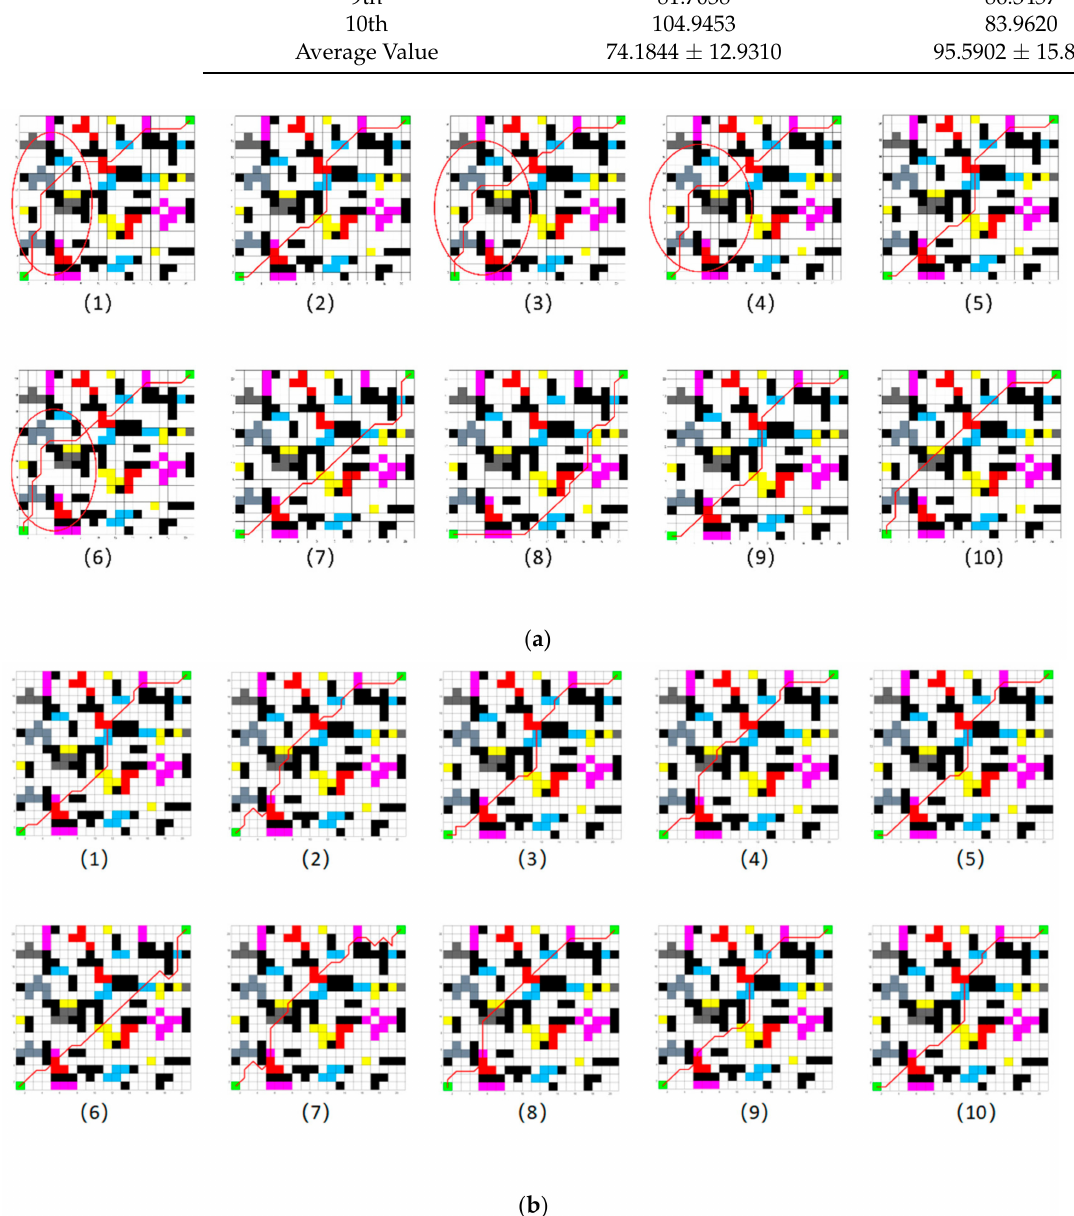
Figure 17. The paths of 20 × 20 grid map generated by: ( a ) MLRMOEGA; ( b )